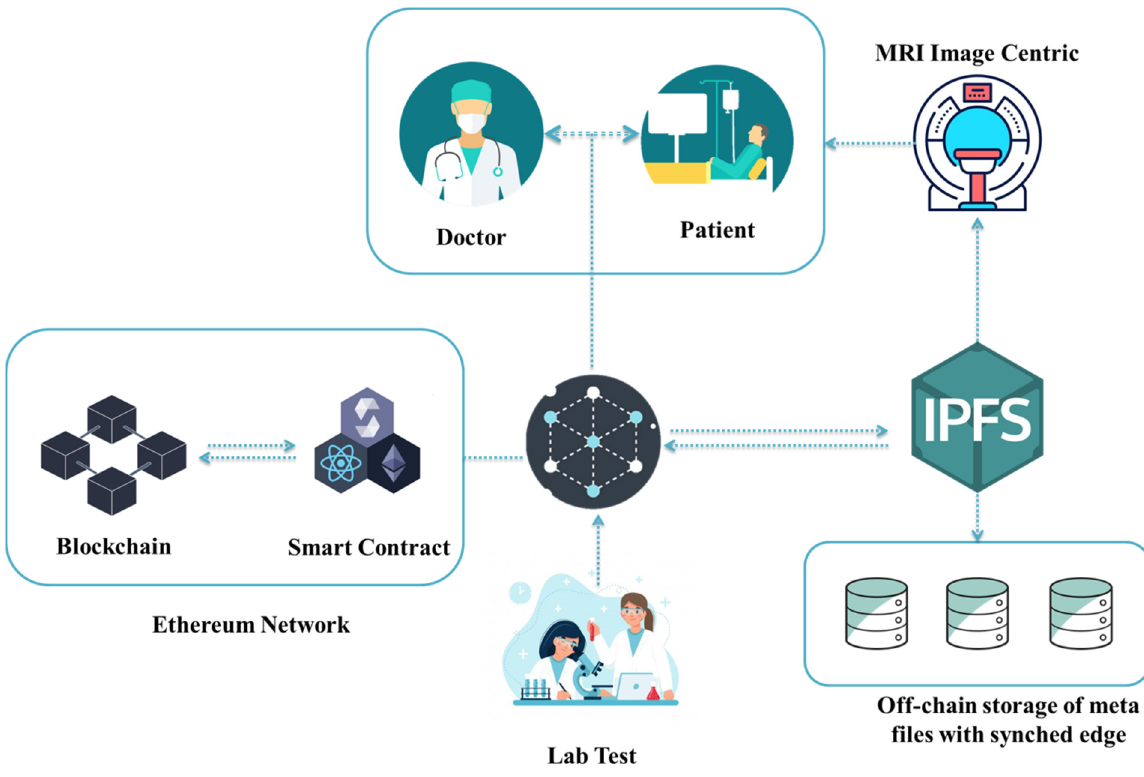
Figure 1. Overview of the proposed solution.